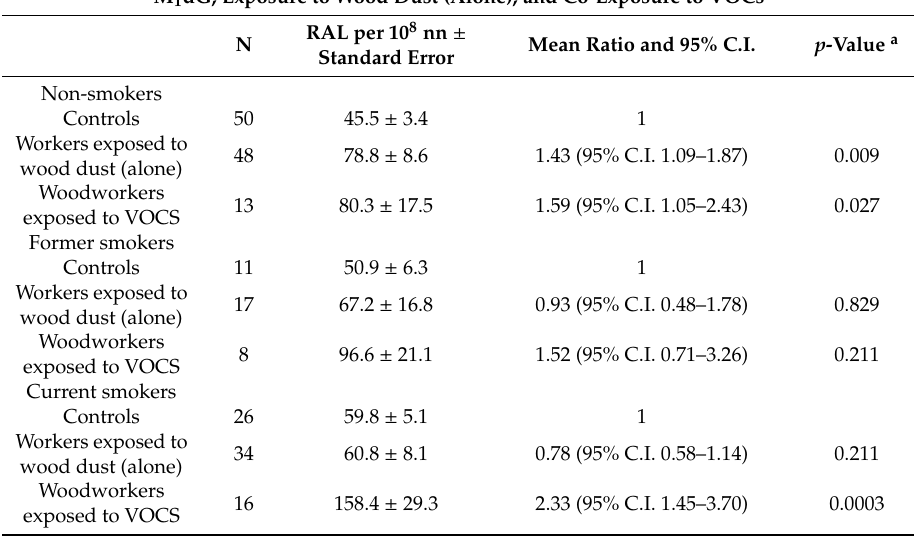
Table 2. Average level of three-(2-deoxy- β -D-erythro-pentafuranosyl)pyrimido[1,2- α ]purin-10(3H)-one deoxyguanosine (M 1 dG), expressed as relative adduct level (RAL) per 10 8 normal nucleotides, Mean Ratio (MR), and 95% Confidence Interval (C.I.), by smoking habits and occupational status, i.e., exposure to wood dust alone and co-exposure to volatile organic compounds